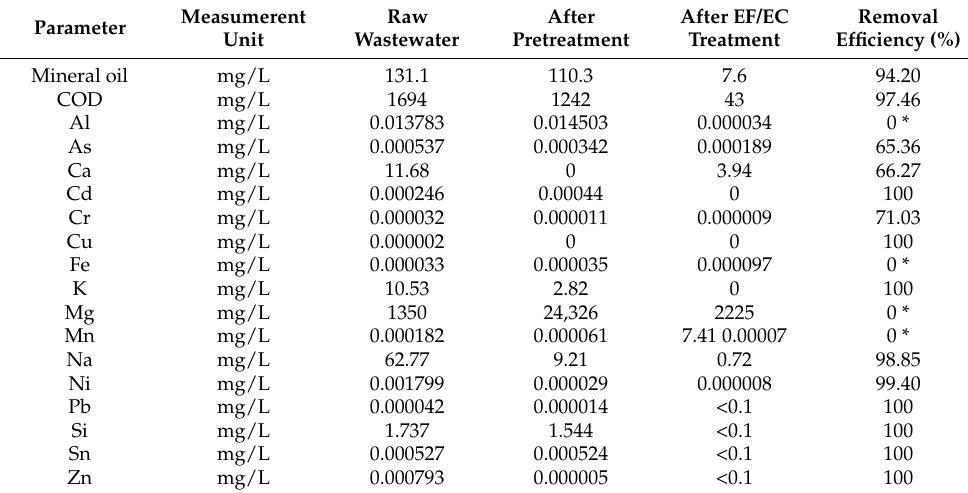
Table 4. Chemical parameters determined in untreated oily wastewater, after primary sedimentation of mixture of raw wastewater with previously generated sludge and after EF/EC process, and final removal